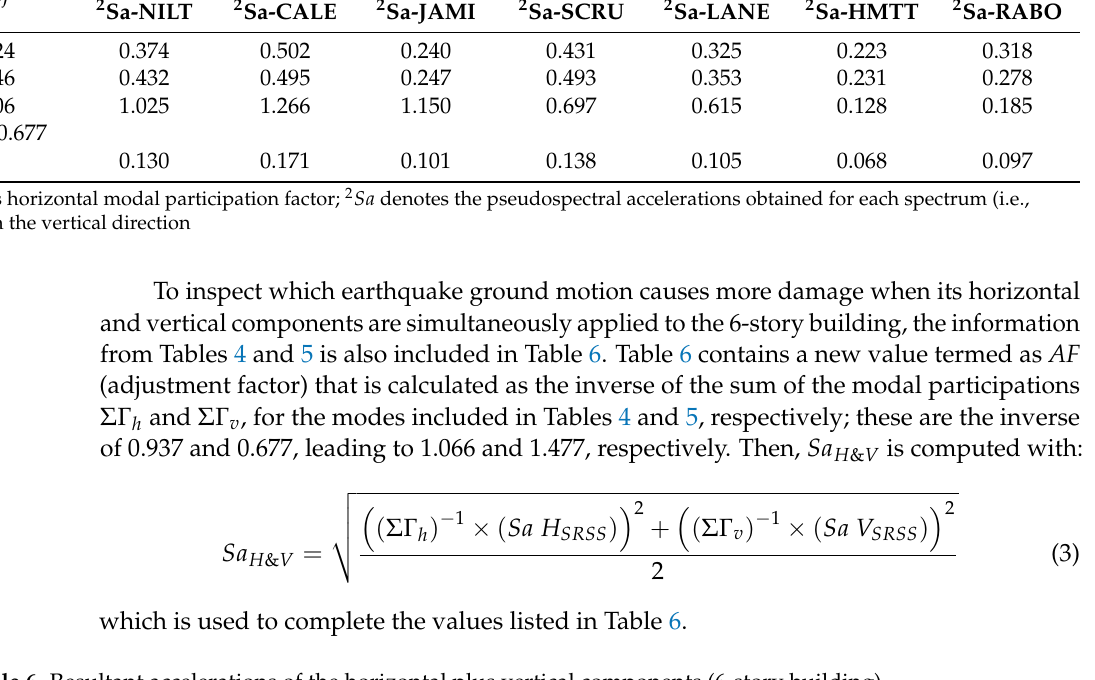
Table 6. Resultant accelerations of the horizontal plus vertical components (6-story